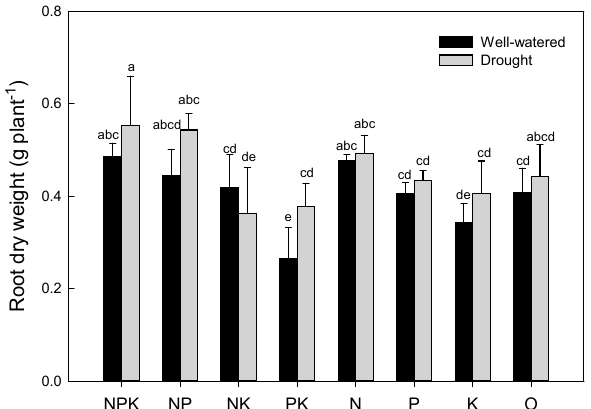
Figure 6. Interactive effects of drought and the N, P and K nutrients applied individually or in combination, or with no nutrient application (0) on the root dry weight of the maize seedlings at day 20 after sowing. The error bars represent the standard errors of the mean ( n = 3) and fit within the plot symbol if not visible. Means accompanied by different letters are significantly different at p < 0.05. Compared with no nutrient supply treatments, the root/shoot DW ratio tended to be reduced by nutrient supply under well-watered conditions and to remain unchanged under drought conditions. However, a significant decrease in the root/shoot DW ratio was found in response to NP and NPK under well-watered conditions and NK and NPK under drought stress compared with no nutrient supply (Figure 7). Drought enhanced the root/shoot DW ratio at day 20 after sowing for all other nutrient treatments except NK supply. A significant increase in the root/shoot DW ratio under drought was found with N, NP, PK and NPK fertilization (Figure 7).